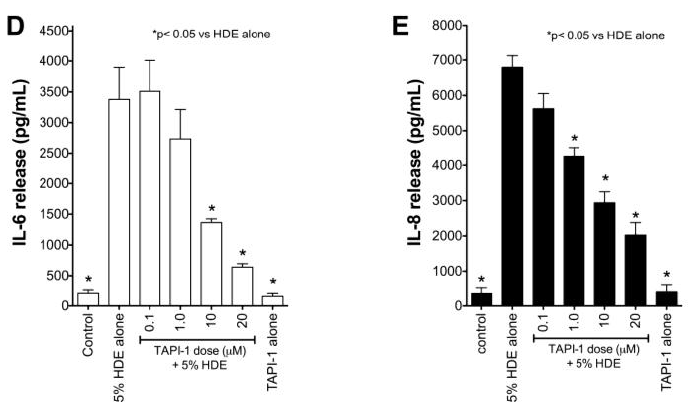
Figure 5. ( A – C ) Pretreatment with TACE inhibitor (TAPI-1) attenuates HDE-mediated ICAM-1 expression ( A ); PMN adhesion ( B ); and TNF α release ( C ) in human bronchial epithelial cells. BEAS-2B cells were treated with control medium, or 5% HDE with or without 20 µM TAPI-1 for 24 h and FACS for ICAM-1, PMN adhesion assays, and TNFα ELISA on supernates were performed. Bar graphs represent mean values with standard error bars ( N = minimum of 3 independent experiments), * p < 0.05 vs. control medium, # p < 0.05 vs. HDE. ( D , E ) Pretreatment with TAPI-1 dose-dependently decreases HDE-induced cytokine release from BEAS-2B. BEAS-2B were treated with culture medium alone, 5% HDE, 20 µM TACE inhibitor TAPI-1 alone, or were pretreated with various doses of TAPI-1 for 1 h before exposure to 5% HDE in the presence of TAPI-1 for 24 h. Conditioned supernatant media were assayed for IL-6 (panel D ) and IL-8 (panel E ) by ELISA. Bar graphs represent the means with standard error bars of 3 independent experiments (* p < 0.05 vs. HDE alone).